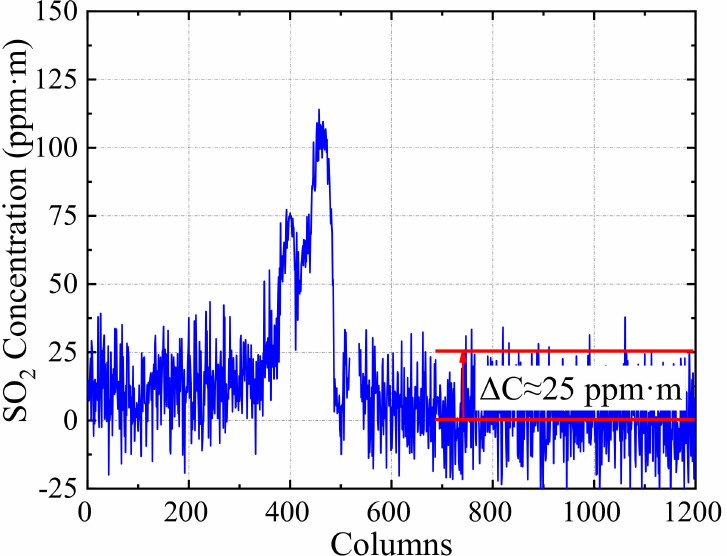
Figure 11. The SO 2 concentration found along the white line in Figure 10. Detection limit of the camera system at 3.5 km is about 25 ppm ·